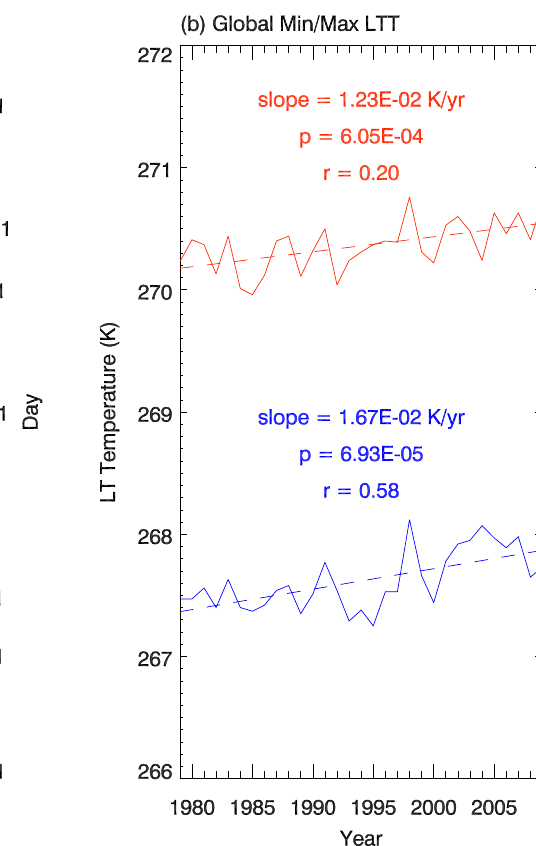
Figure 1. (a) Plot of the date of the maximum and minimum global MSU lower tropospheric temperature as indicated by the fraction of the year starting in December of the previous year (the actual dates are given for reference as well) for the period 1979 to 2009. The red lines are the maxima and the blue lines are the minima. The dashed lines are best fit straight lines to the data (see text, with the slopes given) which are insignificant at the 5% level (as indicated by the values of p). The autocorrelation coefficients (r) have a minimal effect on the values of p. (b) Values of the annual maxima and minima of the globally-averaged lower tropospheric temperatures. The maxima are in red, and the minima are in blue. The best fit straight lines are shown as the dashed lines which are significant at the 5% level (as indicated by the values of p). The autocorrelation coefficients (r) have a minimal effect on the values of